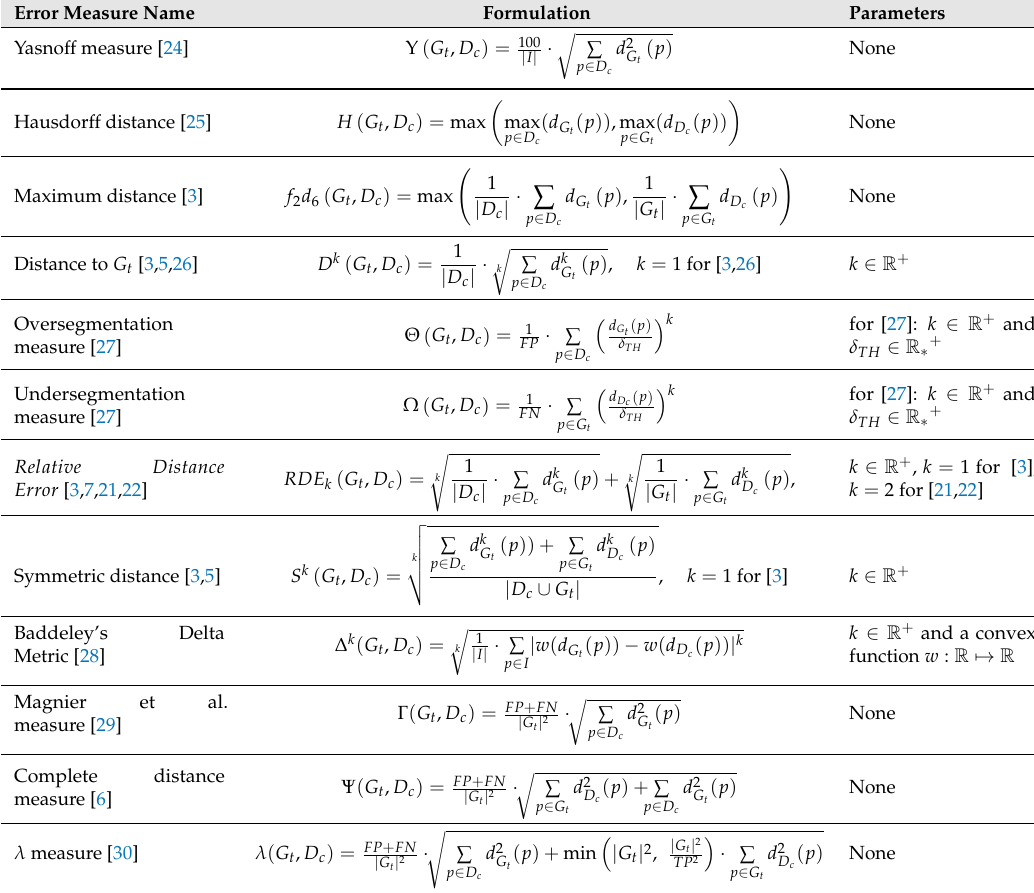
Table A1. List of error measures involving distances, generally: k = 1 or k =